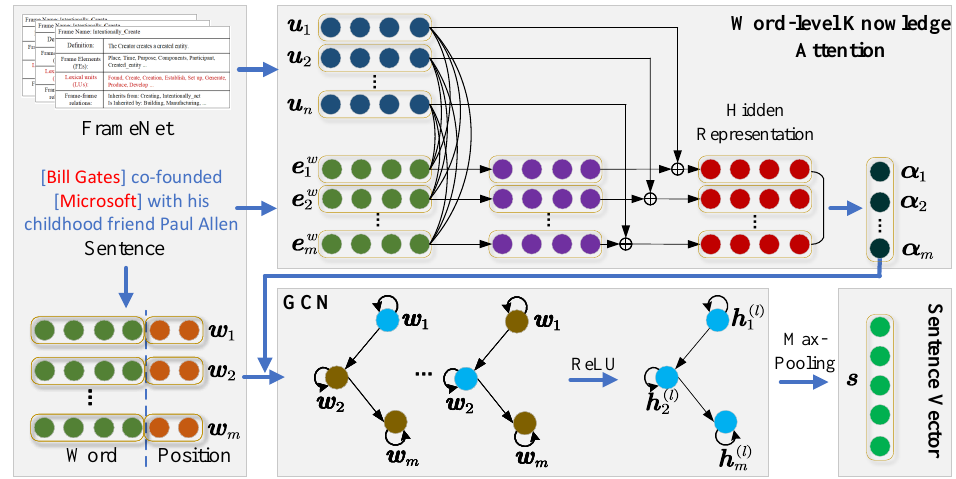
Figure 2. The framework of the sentence embedding module. The upper right part illustrates the generation of the word-level knowledge attention. The lower right part is the knowledge attention based graph convolutional network, which calculates the vector representation of input